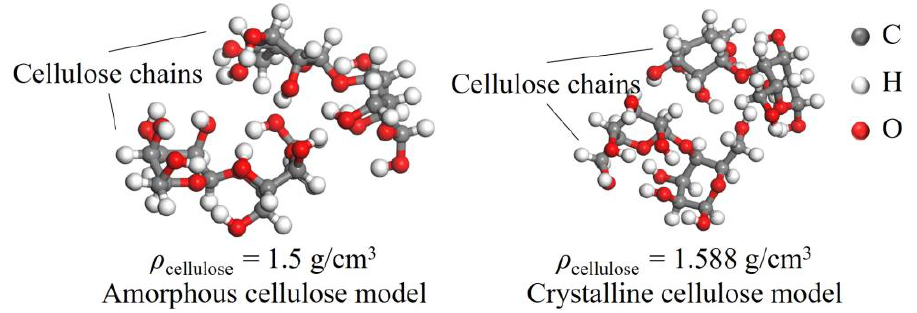
Figure 11. Cellulose molecular model with density of 1.5 g/cm 3 ( left ) and 1.588 g/cm 3 ( right ).